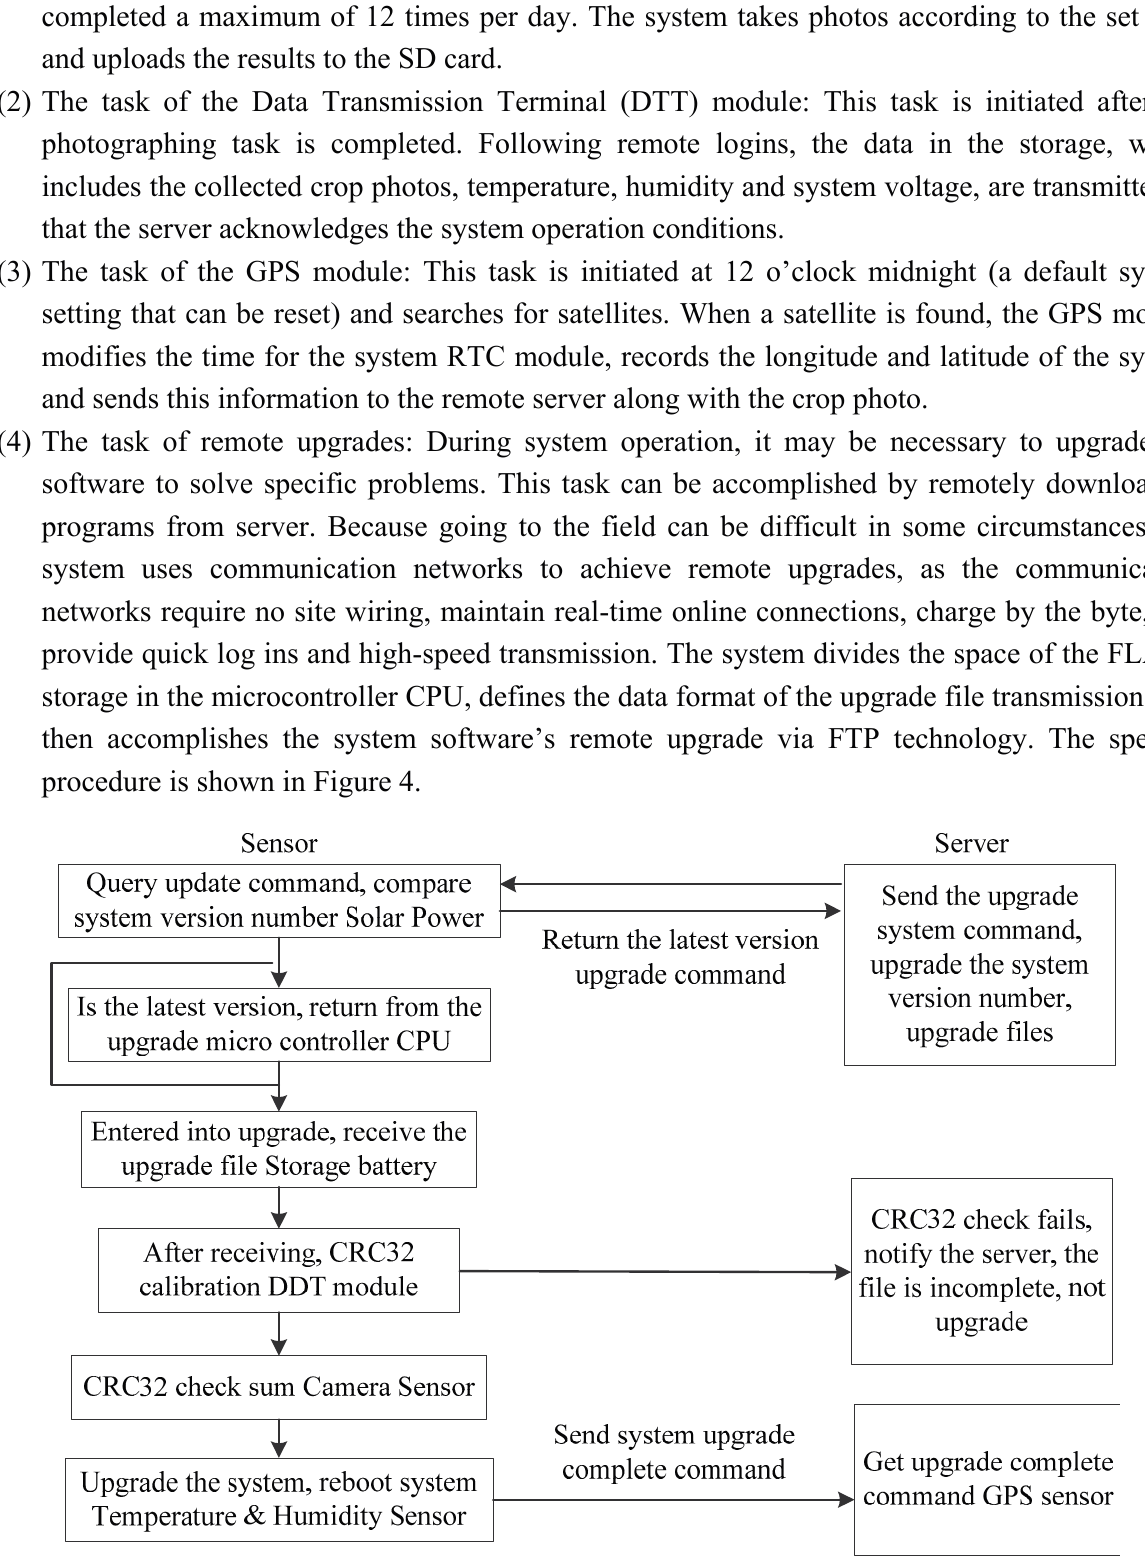
Figure 4. Flow chart of the remote upgrade